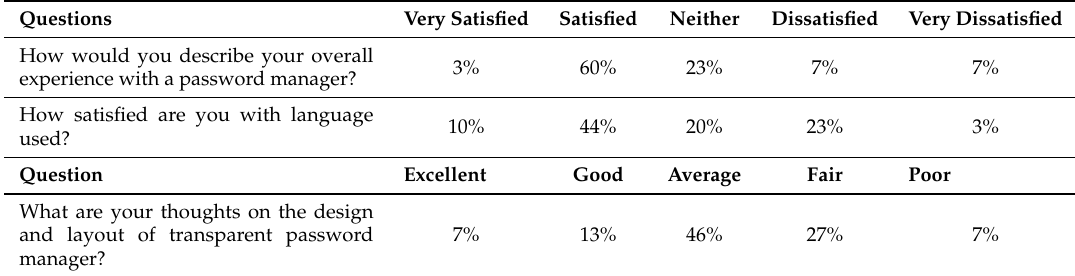
Three Questions Were Answered by 30 Participants about Their Satisfaction